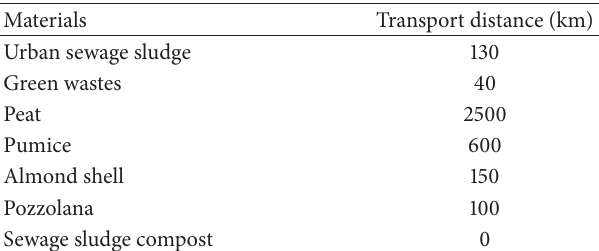
Table 8: Raw materials used for the production of the tested growing media and their transport distance from the production areas to the